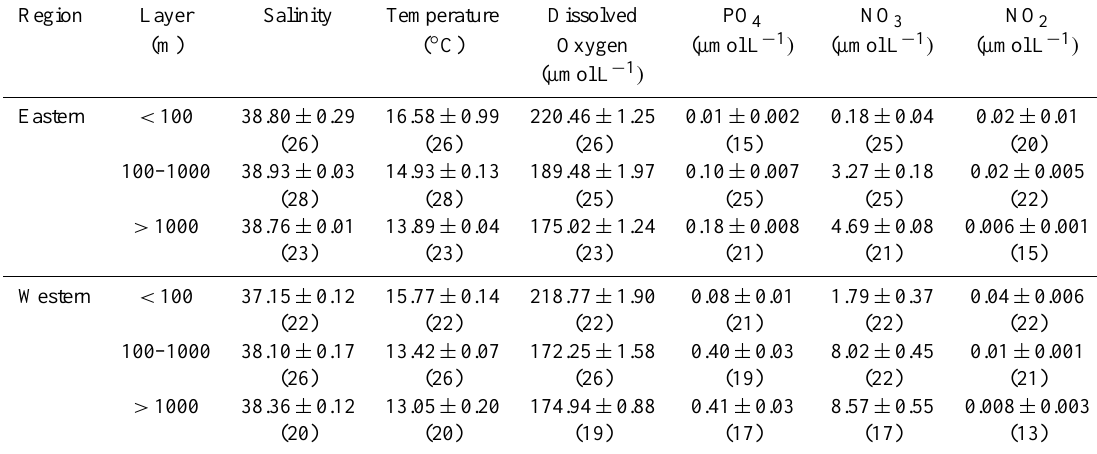
Table 1. Region name, layer, physical parameters (salinity and temperature) and chemical parameters (phosphate, nitrate and nitrite) of the stations sampled during the M84/3 Meteor cruise. Mean ± SD are given for the epi-, meso- and bathypelagic waters. Numbers between brackets indicate the number of